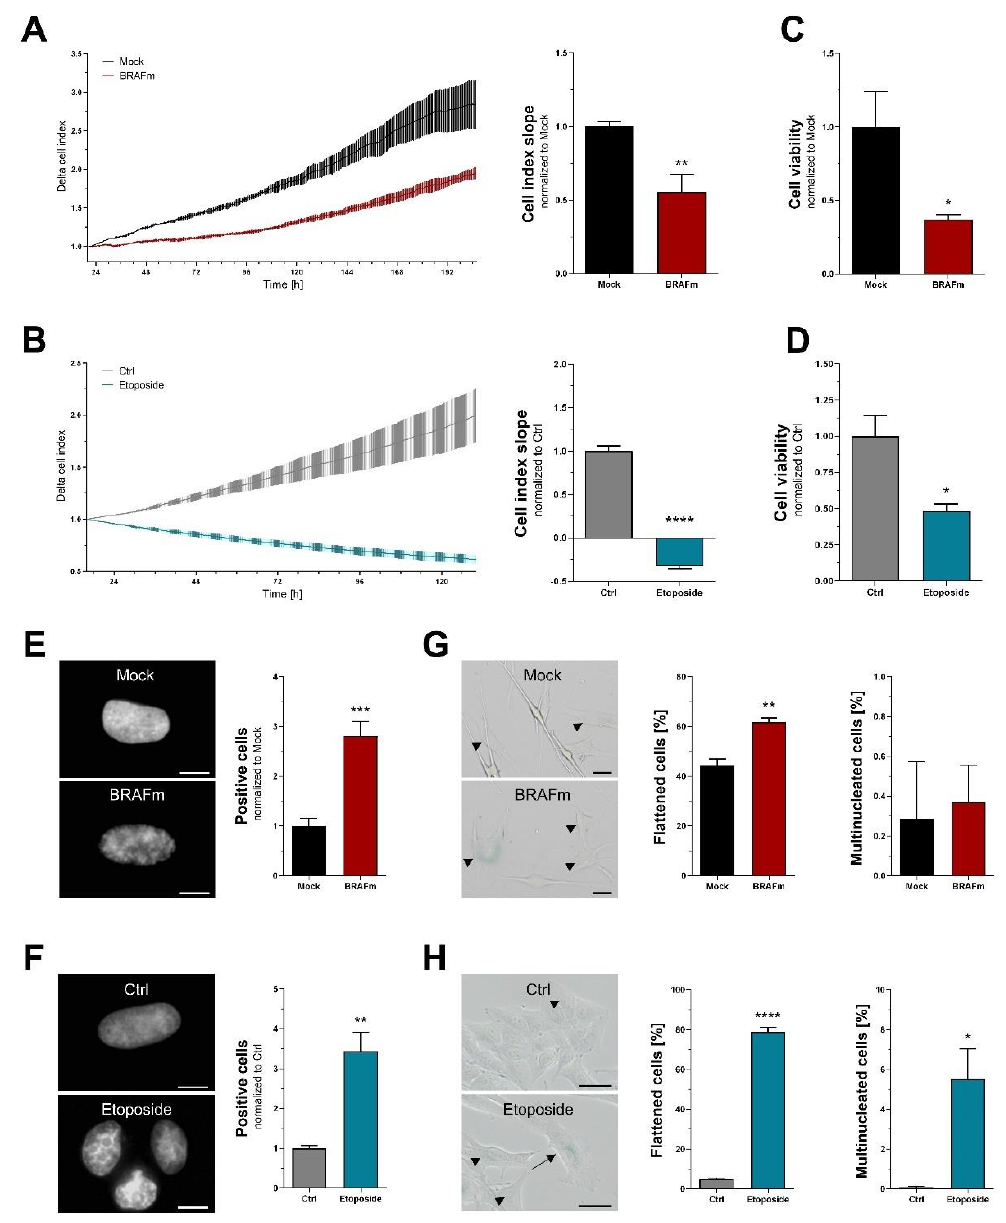
Figure 3. Functional and morphological markers of senescence. RTCA assay using ( A ) NHEM (n = 7) and ( B ) melanoma cell line Mel Juso (n = 3). A representative example is shown on the left. ( C , D ) Cell viability analysis 7 days (NHEM, n = 7) or 48 h (Mel Juso, n = 3) after treatment. ( E , F ) Detection of cells with visible SAHF using DAPI staining. Scale bars equal 10 µm. ( G , H ) Quantification of flattened and multinucleated cells. Arrowheads indicate flattened cells, arrows mark multinucleation. Scale bars equal 20 µ m. Bars are shown as mean ± SEM (Student’s t -test). (*: p < 0.05, **: p < 0.01, ***: p < 0.001, ****: p <